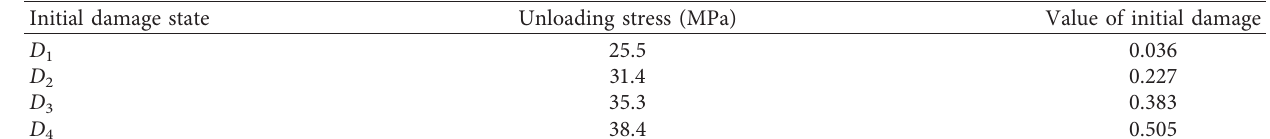
Table 2: Values of the initial damage variable for different specimens.